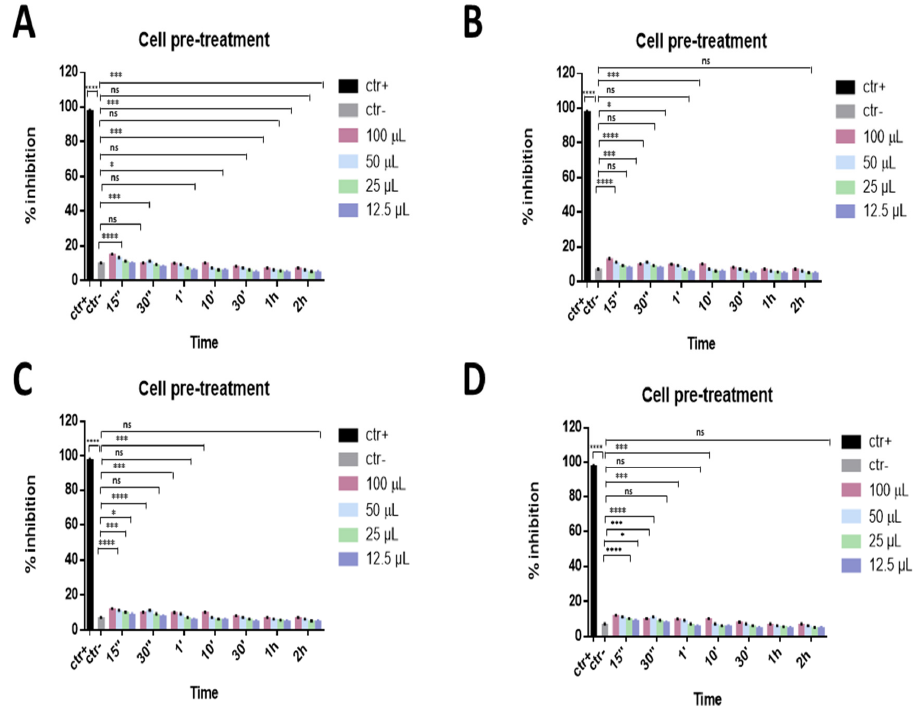
Figure 4. Cell pre-treatment assay. Antiviral activity against SARS-CoV-2 of eye drops at different times of stimulation. Iodim ( A ), Ozodrop ( B ), Dropsept ( C ), and Septavis ( D ) were first incubated on the cell monolayer prior to infect them. Iodim, Ozodrop, Dropsept, and Septavis were not able to interact with the cellular surface. * p = 0.001;*** p = 0.0001; **** p < 0.0001; ns: non-significant.